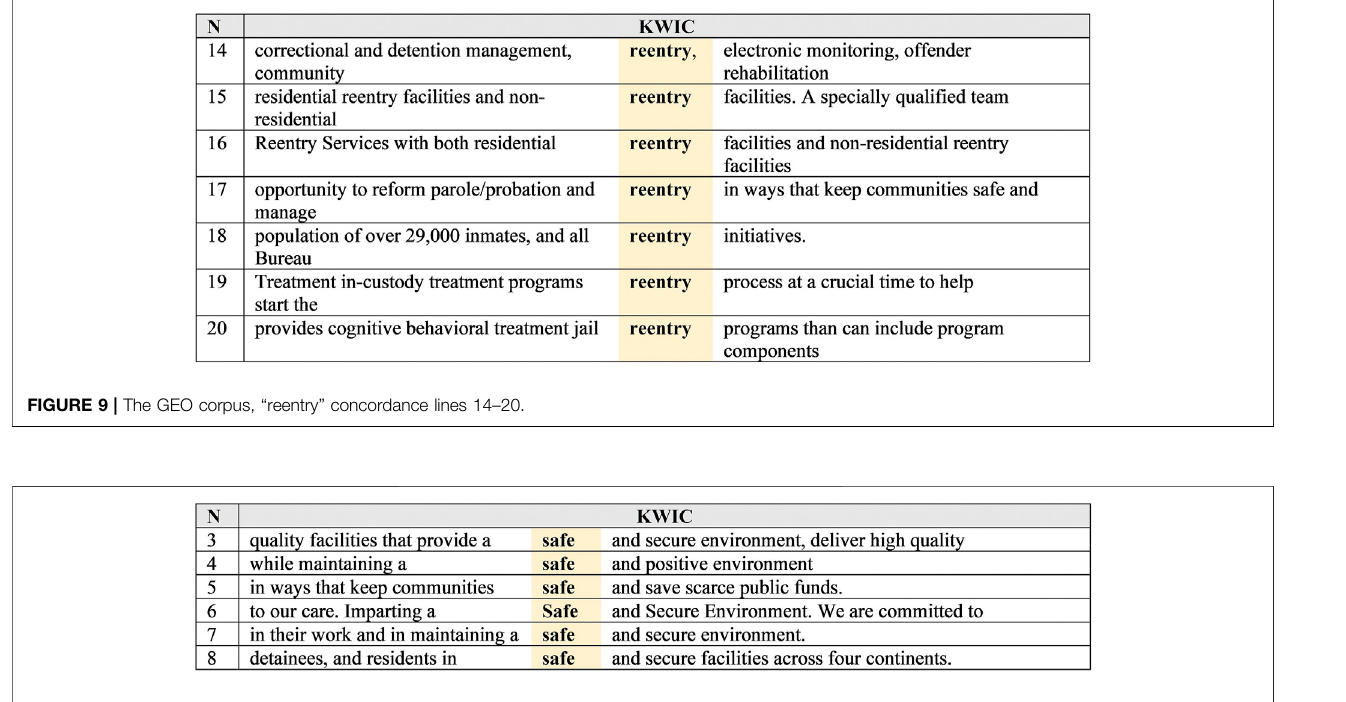
FIGURE 10 | The GEO corpus, “ safe ” concordance lines